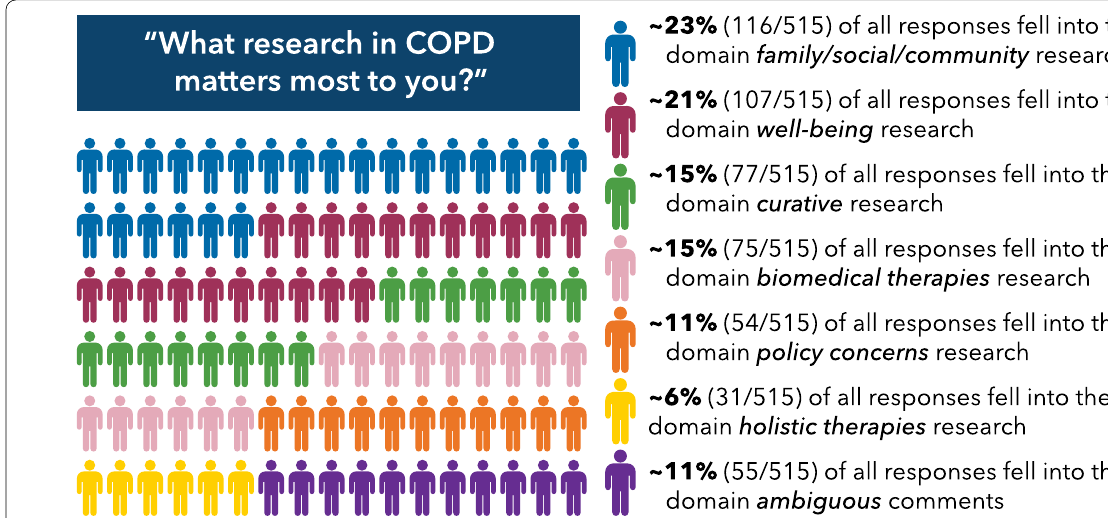
Fig. 2 Results from categorizing participant responses to research